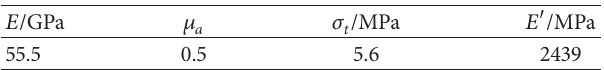
Table 3: Macroscale mechanical parameters for aggregates and asphalt